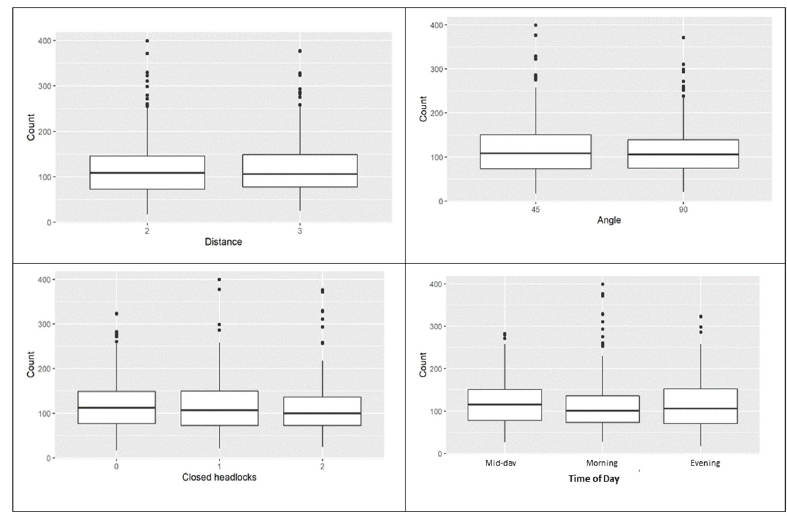
Figure 3. Distribution of P_MEAN (ppm-m) by distance (top left), by angle (top right), by closed headlock (bottom left), and by time of day (bottom right).